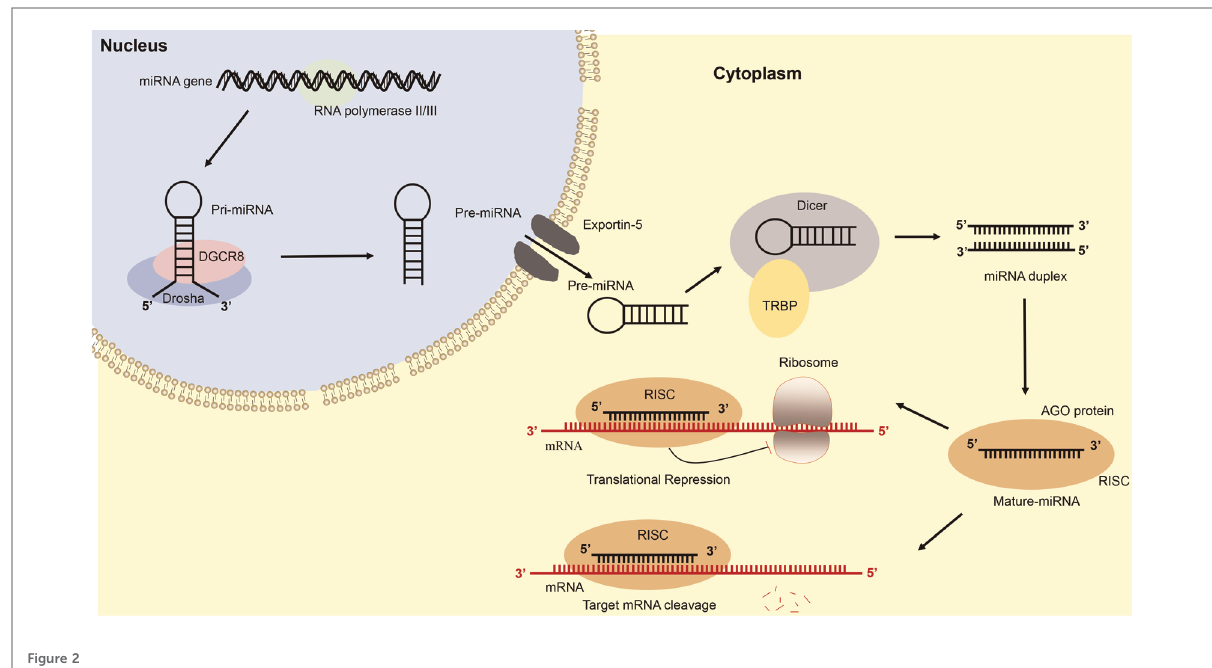
Figure 2 Schematic illustration of microRNA biogenesis and function.